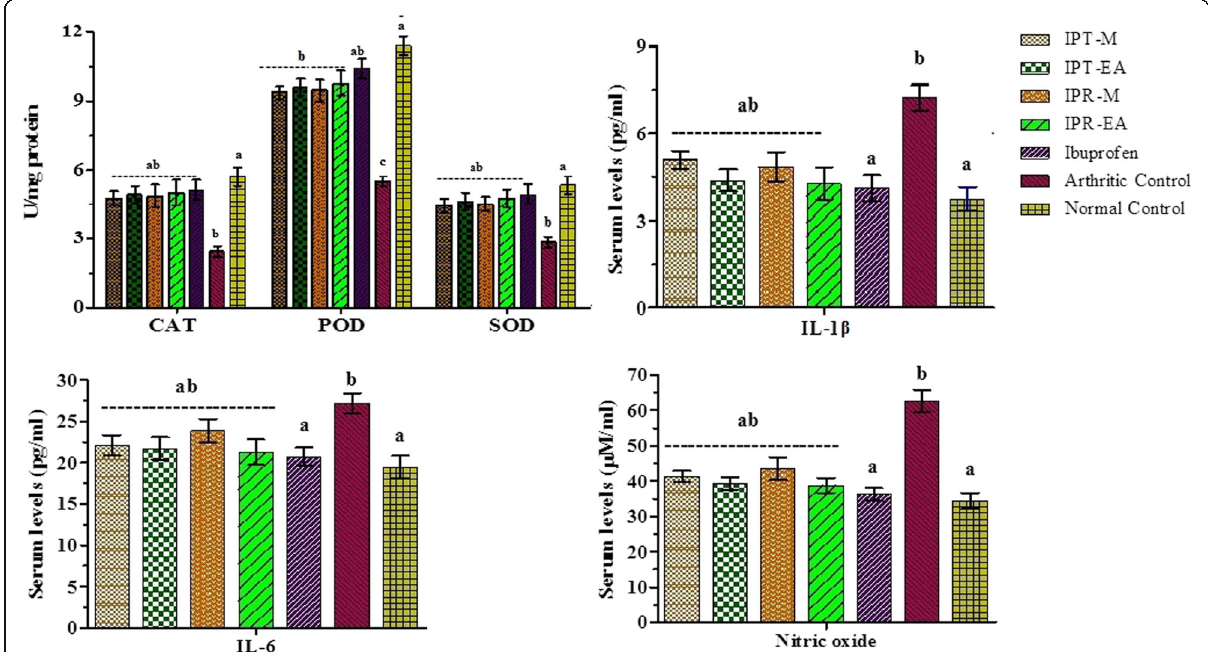
Fig. 8 Effect of Ipomoea batatas extracts on CFA-induced arthritis stimulated endogenous antioxidant enzymes, IL-1 β , IL-6 and NO levels in experimental animals. Catalase (CAT), Peroxidase (POD), Superoxide dismutase (SOD), Interleukin (IL) and Nitric oxide (NO). Data is presented as mean ± SD ( n = 6). Differences were considered significant at the level of * p <